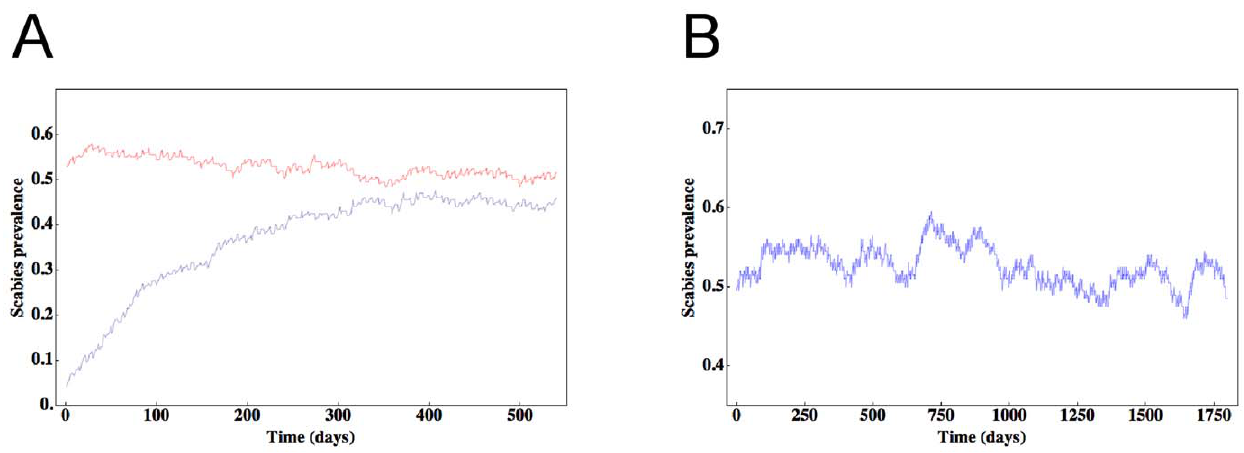
Figure 4. Scabies prevalence. Here we show daily prevalence rates for scenario 2 over a 36-month period (a). Beginning with arbitrary scabies prevalence rates of 0.04 and 0.54, note all relaxation times are , 300 days. Both simulations thus converge and remain at steady-state with stochastic fluctuations. In (b), we track the evolution of a single run of scenario 2 daily and at equilibrium over 5 years, with a magnified prevalence scale to highlight the fluctuations. However, despite the fluctuations, note the time series is stationary; for example, the mean and variance of these data for years 2 and 5 are 0.53 and 0.51, and 4.4 6 10 2 4 and 3.6 6 10 2 4 respectively.